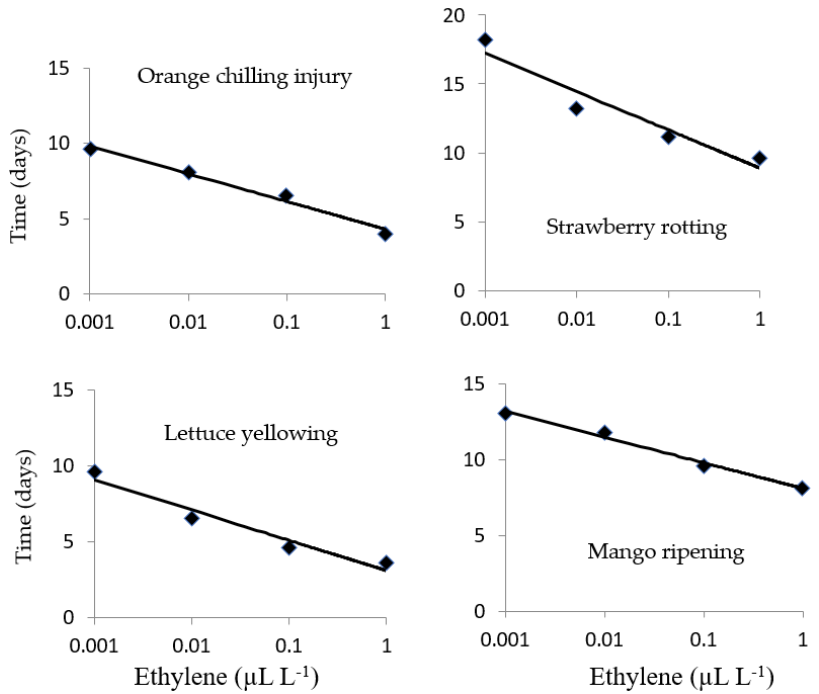
Figure 1. Relationship between ethylene concentration and time (days) for produce to senesce or ripen. Graphs were generated from data given in Wills et al. [15,16].